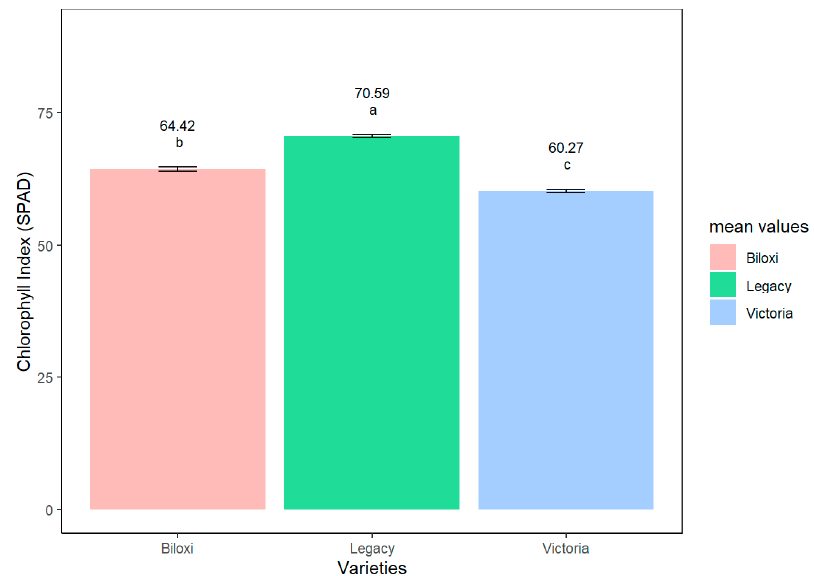
Figure 3. Box-plot of the foliar Magnesium content in Biloxi, Legacy and Victoria variety Blueberry plants cultivated under conditions of the Colombian high tropics.